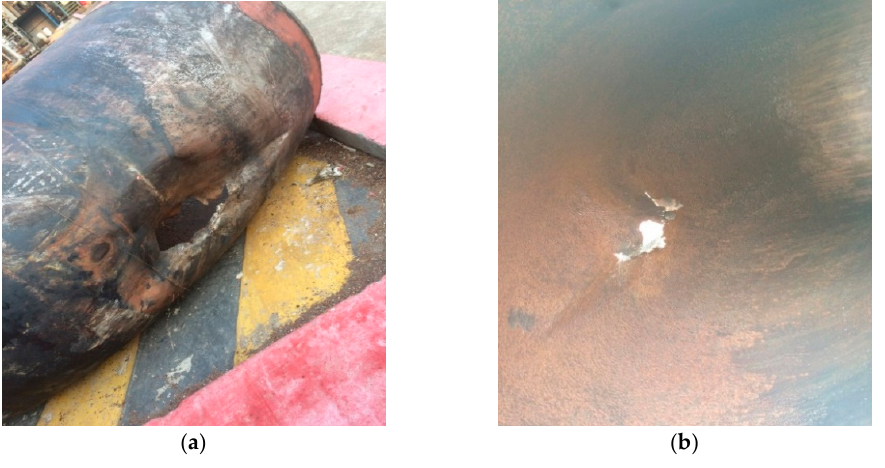
Figure 1. Leakage occurring in the elbow: ( a ) outside view; ( b ) inside view.